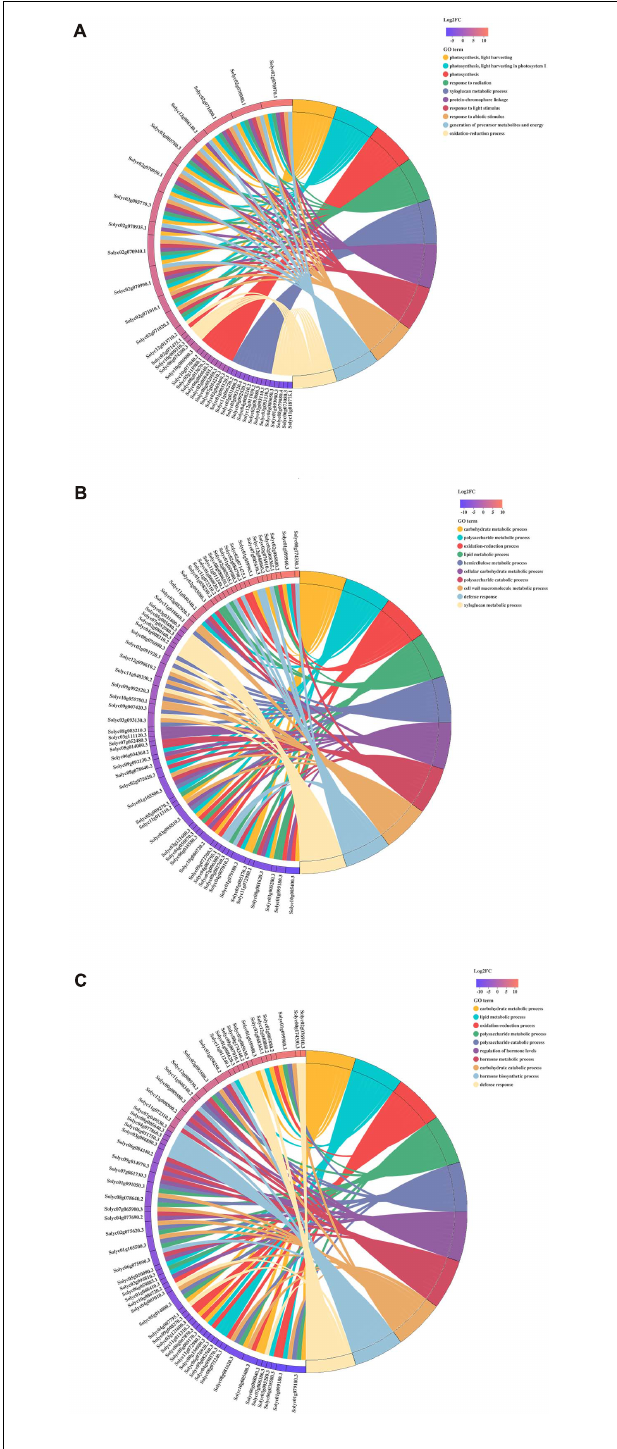
FIGURE 3 | Chord plot of the top 10 Gene Ontology (GO) terms. (A) H_vs_HQ. (B) H_vs_V. (C) H_vs_VQ. Chords show a detailed relationship between the log 2 -fold change (log 2 FC) of differentially expressed genes (DEGs) (left semicircle) and their enriched GO terms (right semicircle). H, healthy tomato plants. HQ, tomato plants was fed on by healthy B. tabaci for 24 h. V, tomato plants was inoculated with ToCV. VQ, tomato plants with ToCV that were fed on by healthy B. tabaci for 24